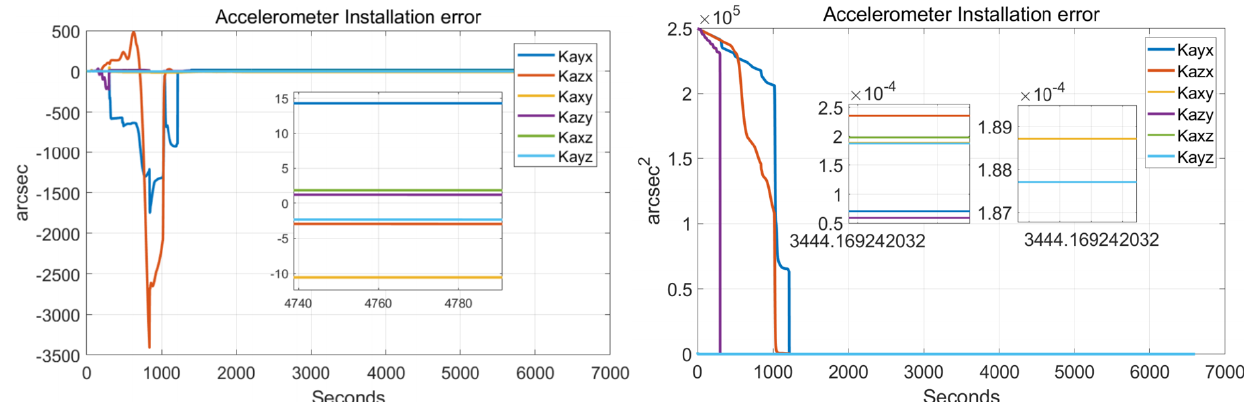
Figure 10. Accelerometer installation